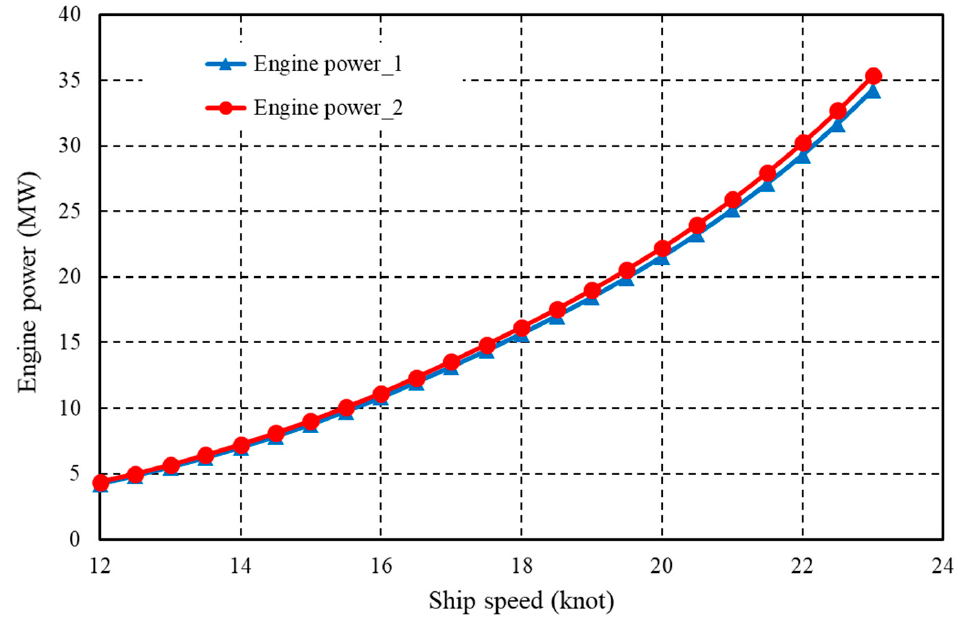
Figure 2. Required power of the propulsion engine depending on the sailing speed.